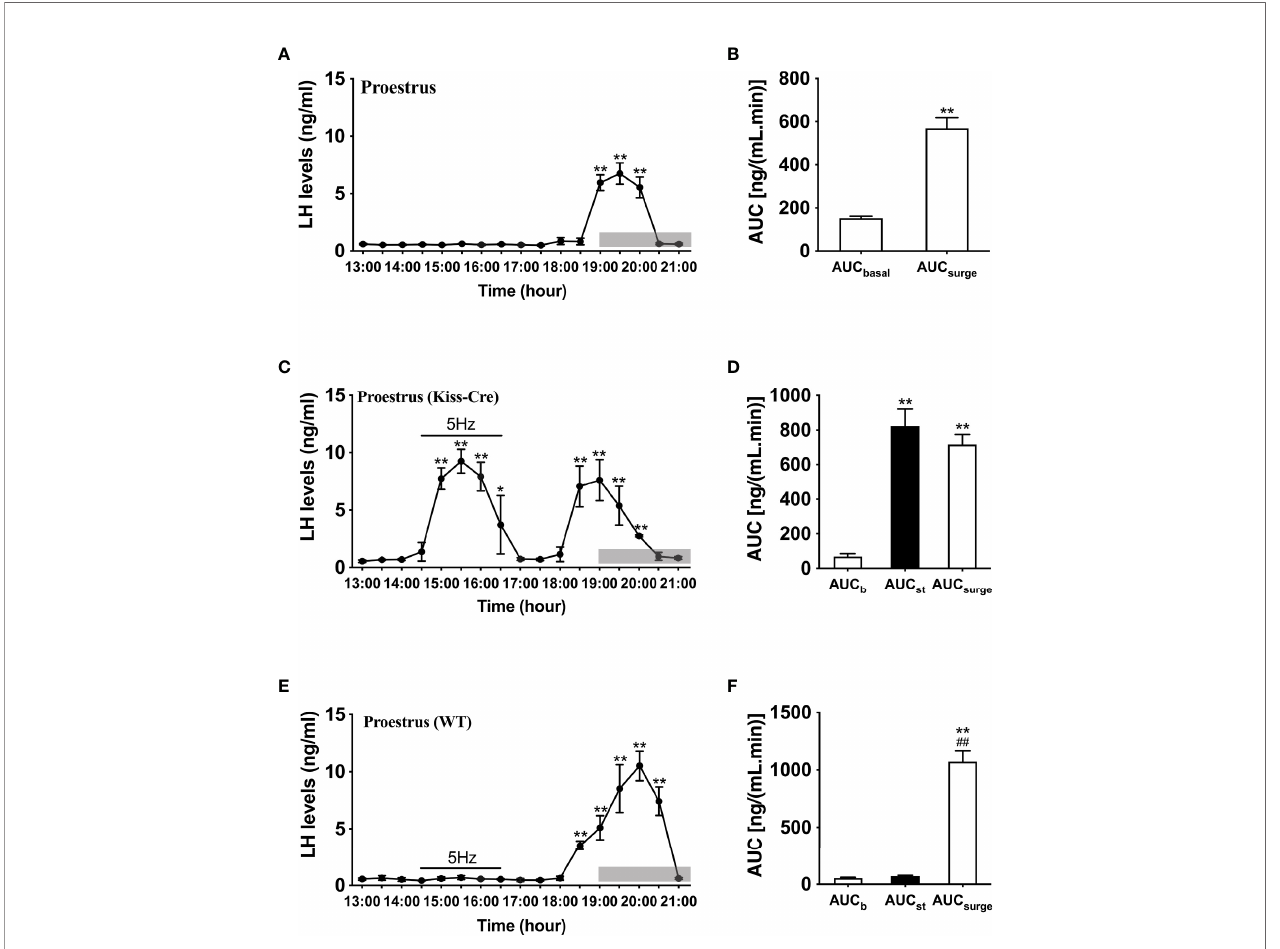
FIGURE 2 | Spontaneous LH surge and LH surge-like response to optogenetic stimulation of ARC kisspeptin in proestrus Kiss-cre mice. (A) Circulating levels of LH (Mean ± SEM) in proestrus Kiss-cre mice sampled at 30-min intervals (13:00 – 21:00 h) showing spontaneous LH surges (n = 6). (B) Area under curve of LH levels for basal (AUC b , 13:00 - 17:30 h) and spontaneous LH surge (AUC surge , 18:30 - 20:30 h) time periods. (C) Evoked LH secretion in response to sustained 5 Hz blue- light stimulations of ARC kisspeptin neuron cell bodies (14:30 - 16:30 h) in Kiss-Cre mice (n = 5). (D) Area under curve of LH levels before stimulation (basal) (AUC b , 13:00 - 14:30 h), during stimulation (AUC st , 14:30 - 16:30 h) and during the spontaneous surge (AUC Surge , 18:00 – 20:30 h) (n = 5). (E) LH levels of wild type (WT) mice sampled at 30-min intervals and subjected to same optic stimulation protocol as Kiss-cre mice (n = 4). (F) Area under curve of LH levels before stimulation (AUC b , 13:00 - 14:30 h), during stimulation (AUC st , 14:30 - 16:30 h) and during the spontaneous surge (AUC Surge , 18:00 - 21:00 h). *P < 0.05 and **P < 0.01 (unpaired t-test) relative to basal LH levels or AUC for basal LH levels. ## P< 0.01 indicates a signi fi cant difference relative to AUC for stimulation period. Lights off is at 19:00 h for all experiments, as indicated by the grey bar on the